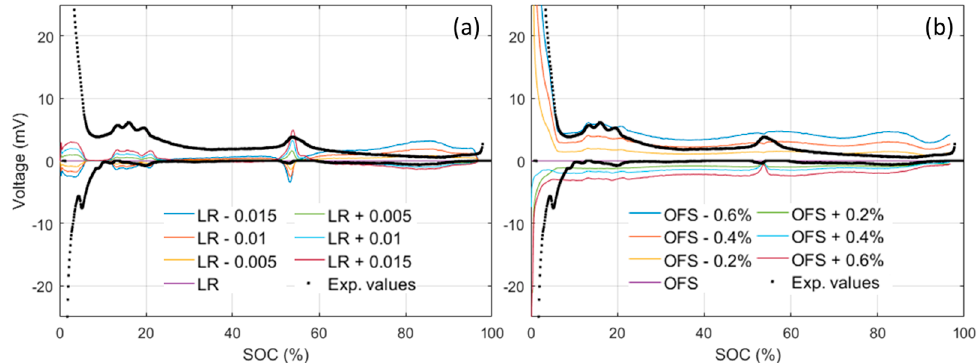
Figure 7. Impact of ( a ) loading ratio ( LR ) variations and ( b ) offset ( OFS ) variation on the ps- OCV = f ( SOC ) compared to the OCV curve obtained from the baseline LR (0.96) and OFS (2.8%) model used in this study.